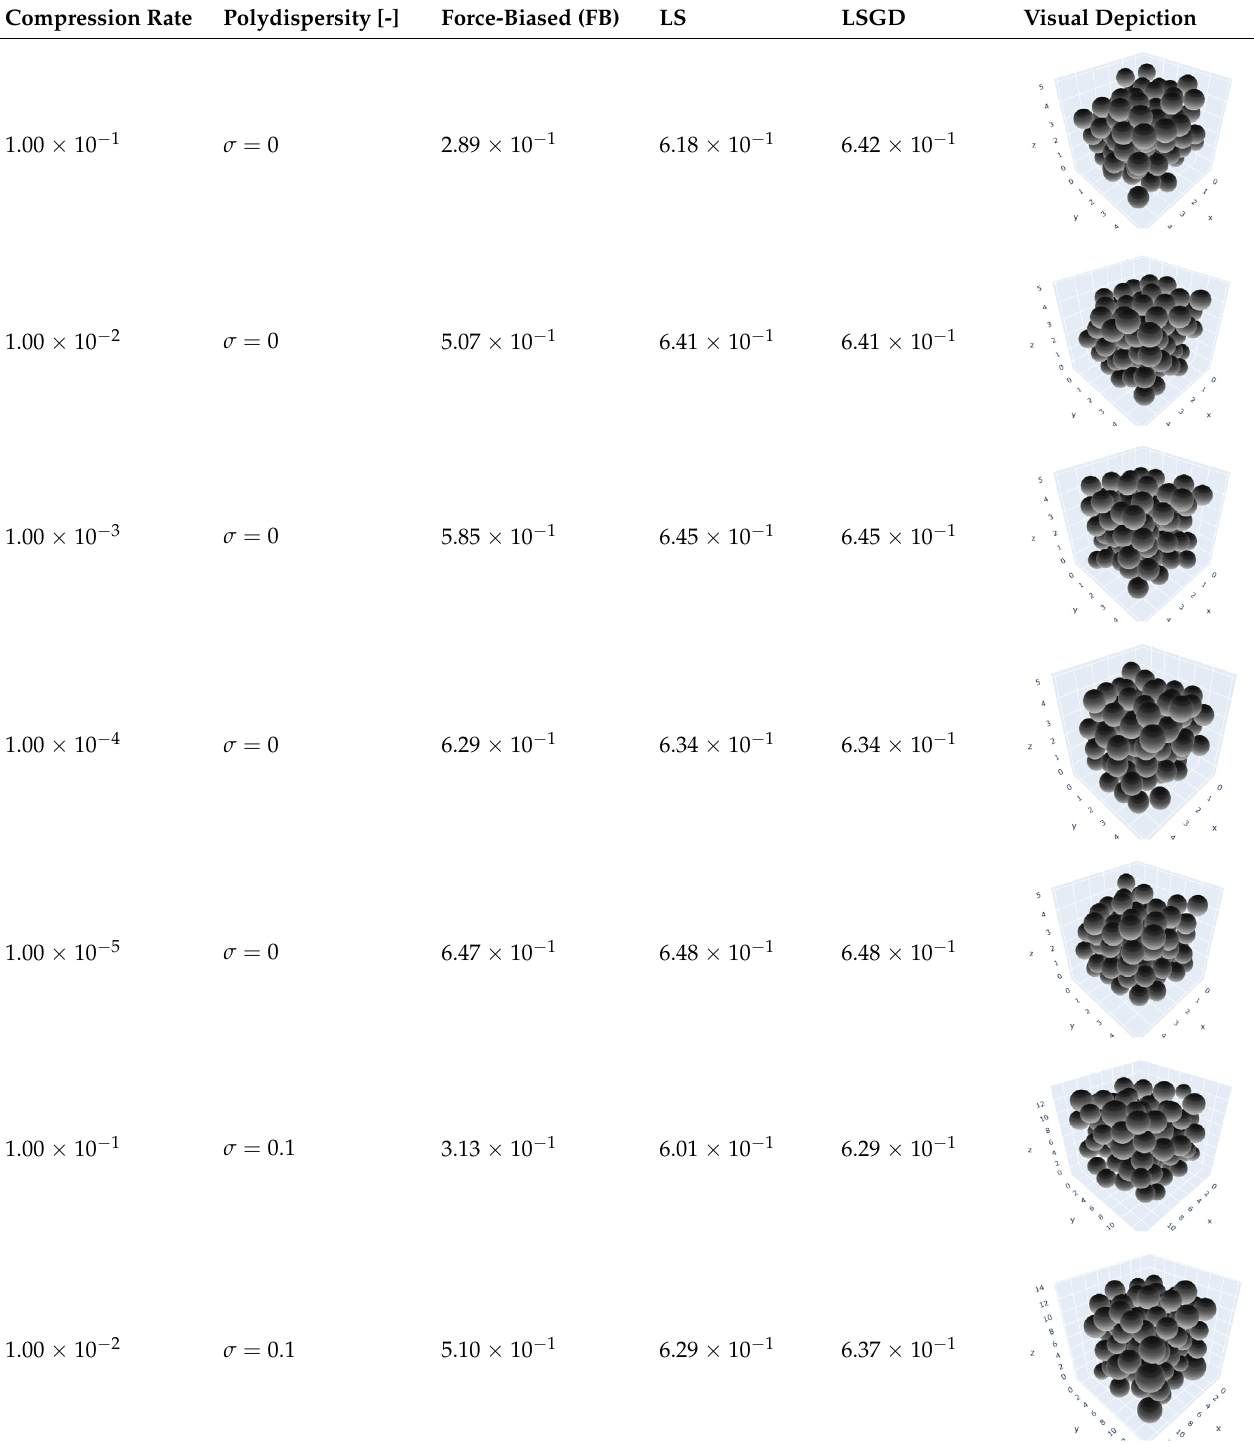
Table 4. Simulation results are tabulated in instances with visual depictions as a function of polydispersity and compression rate.